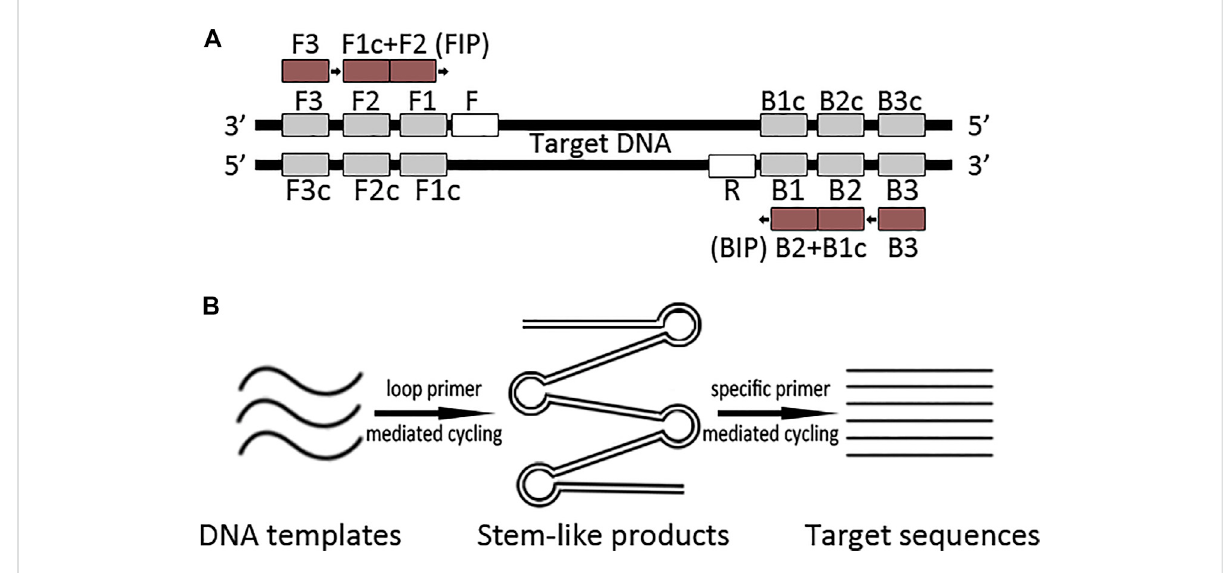
Schematic representation of the L-PCR assay. (A) Primers of the L-PCR assay contain a loop-primer set of four conserved primers which recognizesixtargetDNAregionsandasingleplexPCRprimerset. (B) TheL-PCRassaycomprisestwostages:the fi rststageusesaloop-primersetfor speci fi callyenrichingabroadertargetregionwhichcomprisesthetargetregion;thesecondstageisaroutinePCRprocessthatusesaspeci fi cprimer pair to obtain the target